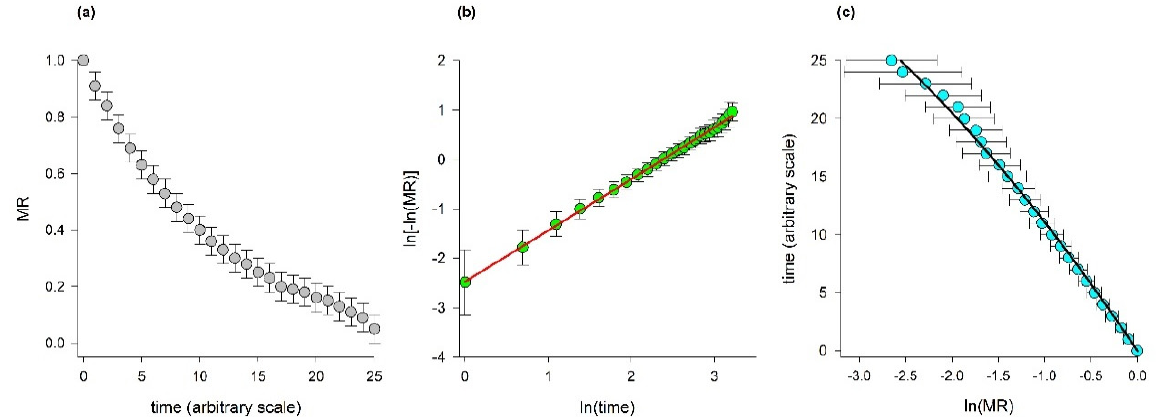
Figure 3. Synthetic drying data with equal error bars ( a ), fit of Diamante model—red line [Equation (4)] to the transformed data, where R 2 = 0.9987 and RMSE = 0.0331 ( b ) and fit of Thompson model—black line [Equation (5)] to the transformed data, where R 2 = 0.9966 and RMSE = 0.4546 ( c ).